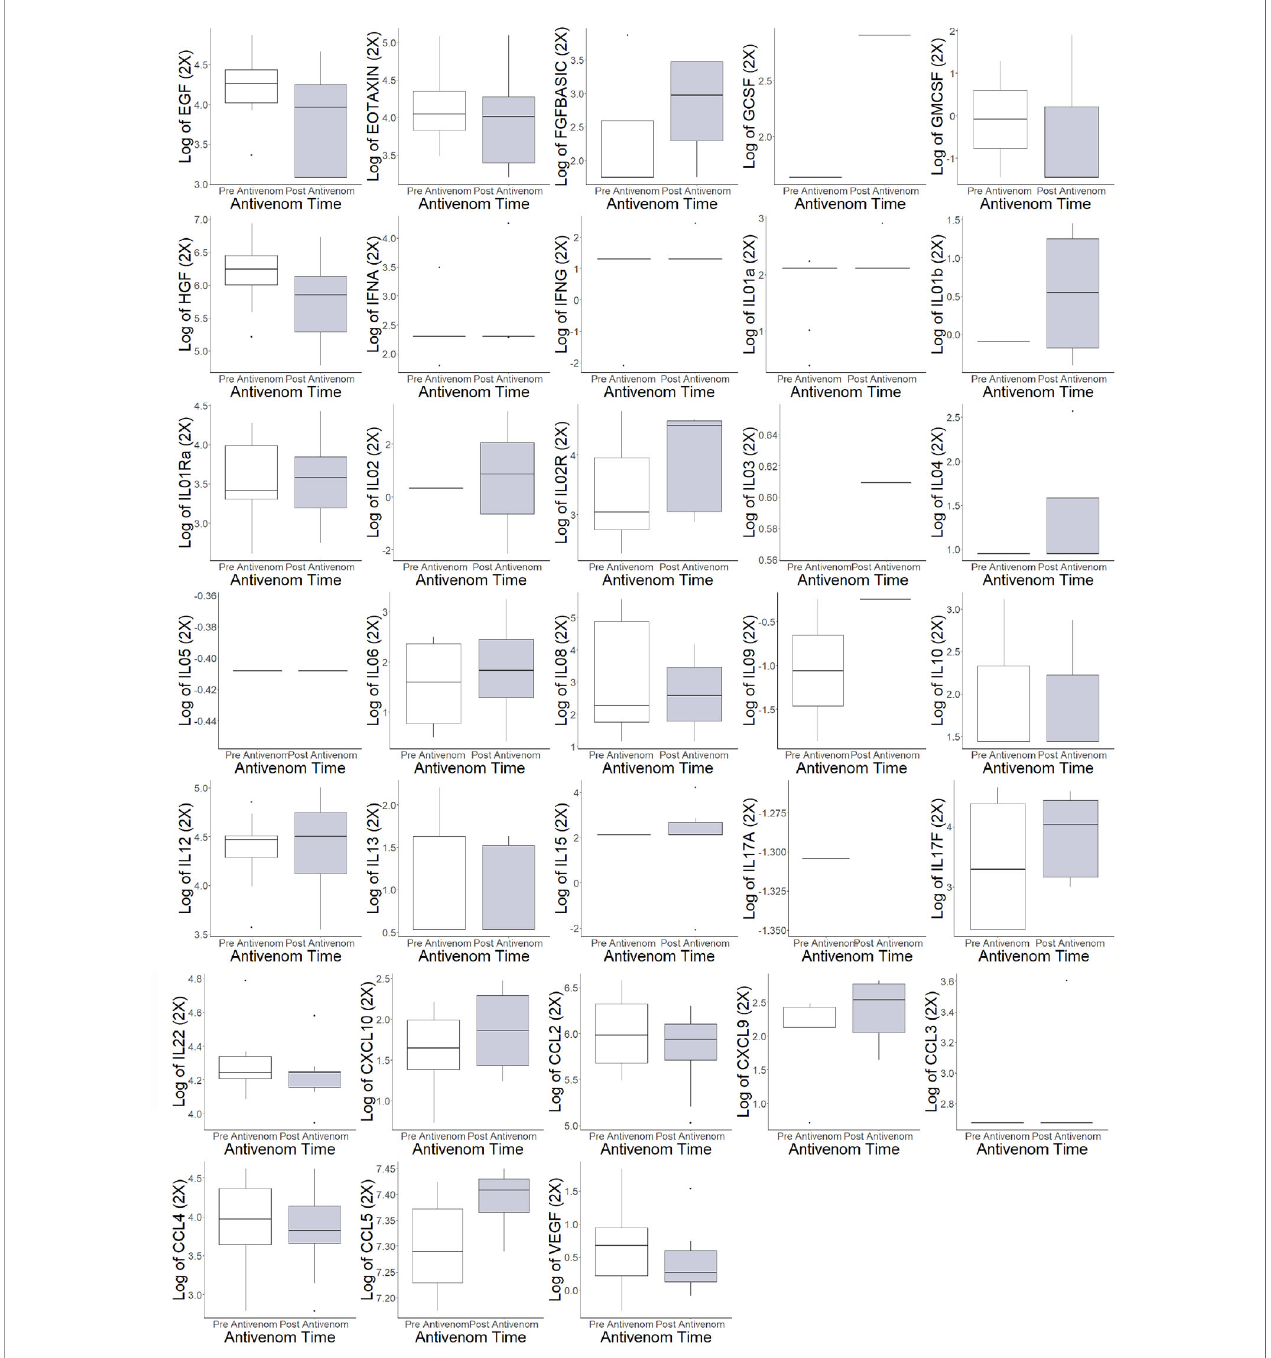
FIGURE 2 | Individual cytokine and chemokine values pre- and post-antivenom treatment. EGF: endothelial growth factor, EOTAXIN: eosinophil chemotactic proteins, *FGFBASIC: fi broblastic growth factor, basic, GCSF: granulocyte colony stimulating factor, GMCSF: ganulocyte-macrophage colony stimulating factor, *HGF: hepatocyte growth factor, IFNA: interferon alpha, IFNG: interferon gamma, IL01interleukin 1a, IL01b: interleukin 1b, IL01Ra: Interleukin 1 receptor antagonist, IL02: interleukin 2,* IL02R: interleukin 2 receptor, IL03: interleukin 3, IL04: interleukin 4, IL05: interleukin 5, IL06: interleukin 6, IL08: interleukin 8, IL09: interleukin 9, IL10: interleukin 10, IL12: interleukin 12, IL13: interleukin 13, IL15: interleukin 15, IL17A: interleukin 17A, IL17F: interleukin 17F, IL22: interleukin 22, CXCL10: C-X-C motif ligand 10, CCL2: C-C motif ligand 2, CXCL9: C-X-C motif ligand 9, CCL3: C-C motif ligand 3, CCL4: C-C motif ligand 4, *CCL5: C-C motif ligand 5, VEGF: vascular endothelial growth factor. *Difference in populations based on box